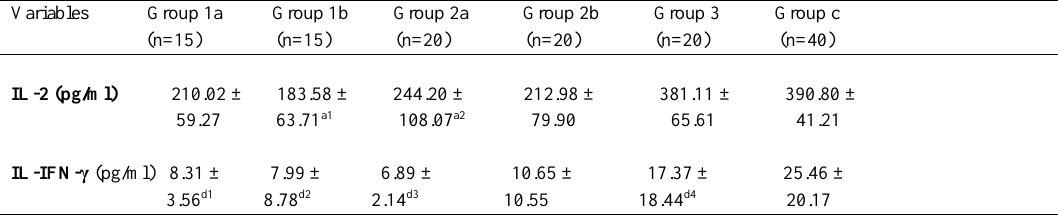
Table 2. Plasma levels of IL-2 and IL-10 in studied